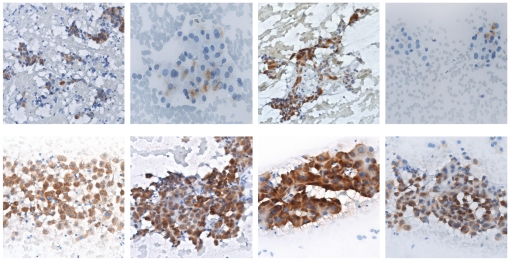
Immunohistochemistry analysis for HURP expression in aspirated human HCC cells in 8 representative cases.HURP was stained in brown color.